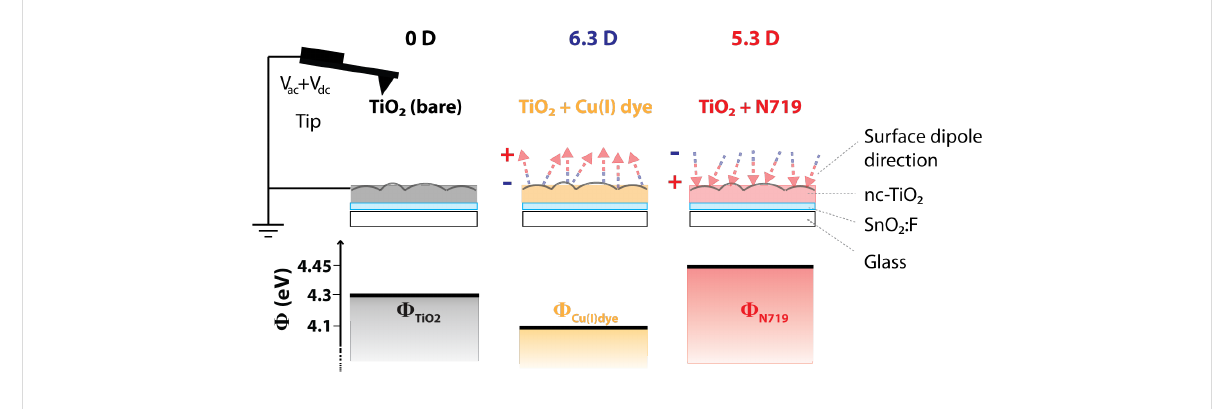
Figure 8: Schematic illustration of the KPFM measurement system and the surface dipole induced by adsorption of the ruthenium containing dye N719 (6.3 D) and the copper(I) dye (5.3 D) pointing in opposite directions. The measured work-function values are compared with the bare TiO 2 sub- strate without external